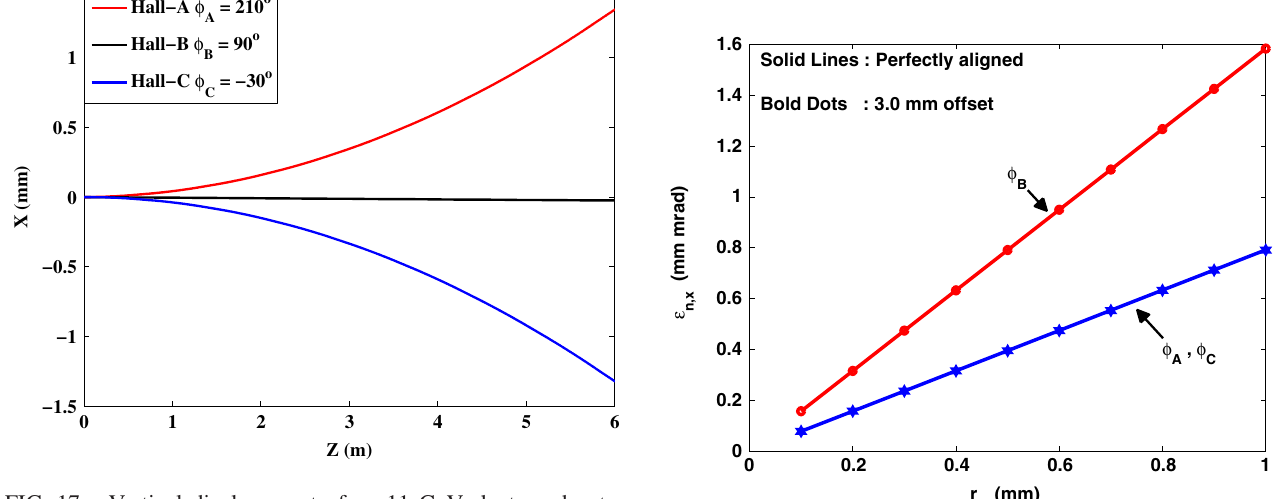
FIG. 17. Vertical displacement of an 11 GeV electron due to eight 2-cell cavities for three different rf phases (cid:4) A;B;C and V ¼ 673 : 2 kV def